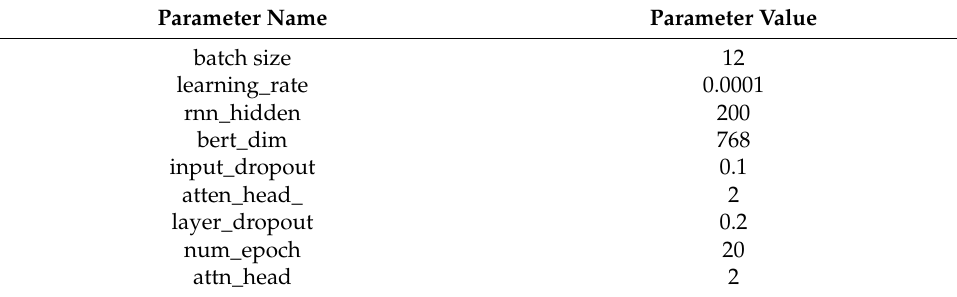
Table 3. Model parameter